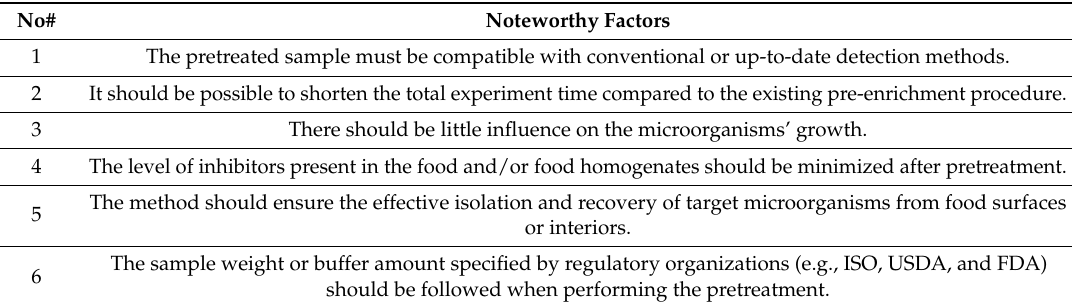
Table 4. Six factors worth consideration to develop the ideal pre-treatment